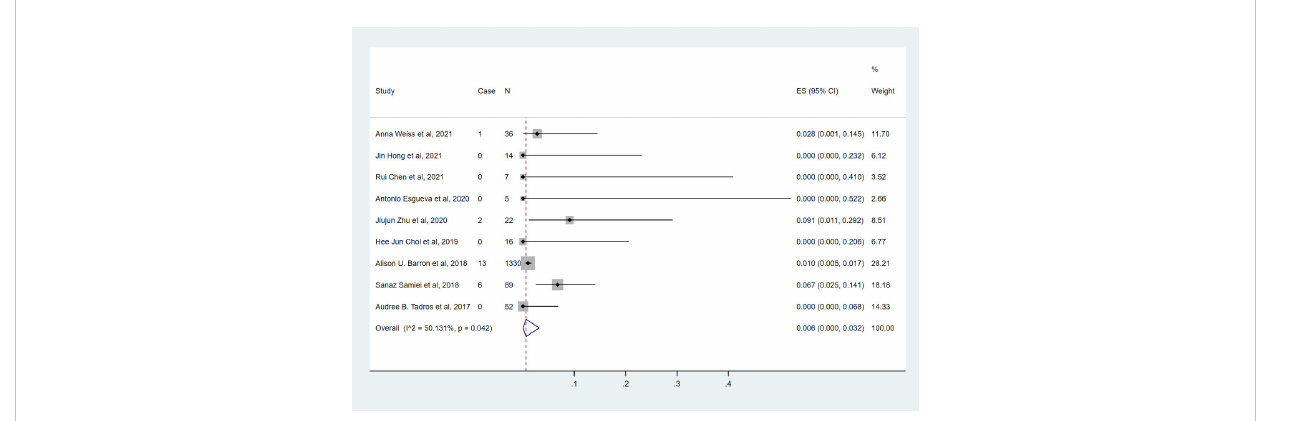
FIGURE 5 The overall pooled ypN+ rate of cN0 patients who achieved bpCR in HR-/HER2+ breast cancer. HR, hormone receptor; HER2, human epidermal growth factor receptor 2. ES, effect size. CI, con fi dence interval. Effect size was used to estimate the ypN+ rate of each study. Con fi dence intervals determine the consistency and reliability of the mean estimated effect size. Diamonds indicate effect size.